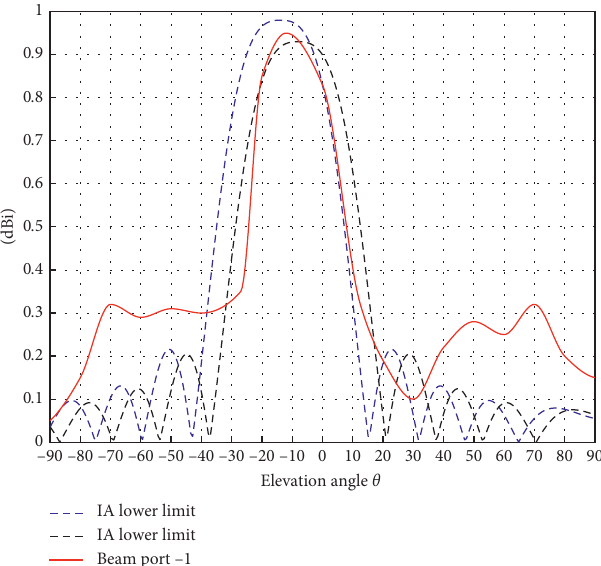
Figure 28: Measured vs. simulated beam pattern considering the lower and upper IA limits. Beam port − 1, beam steering at − 10